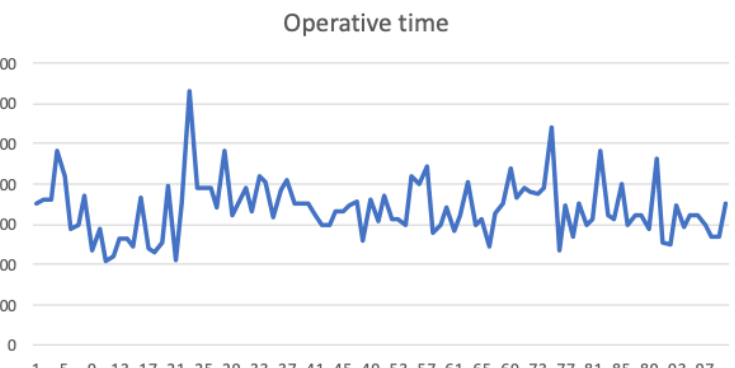
Figure 1. Operative time in consecutive cases.